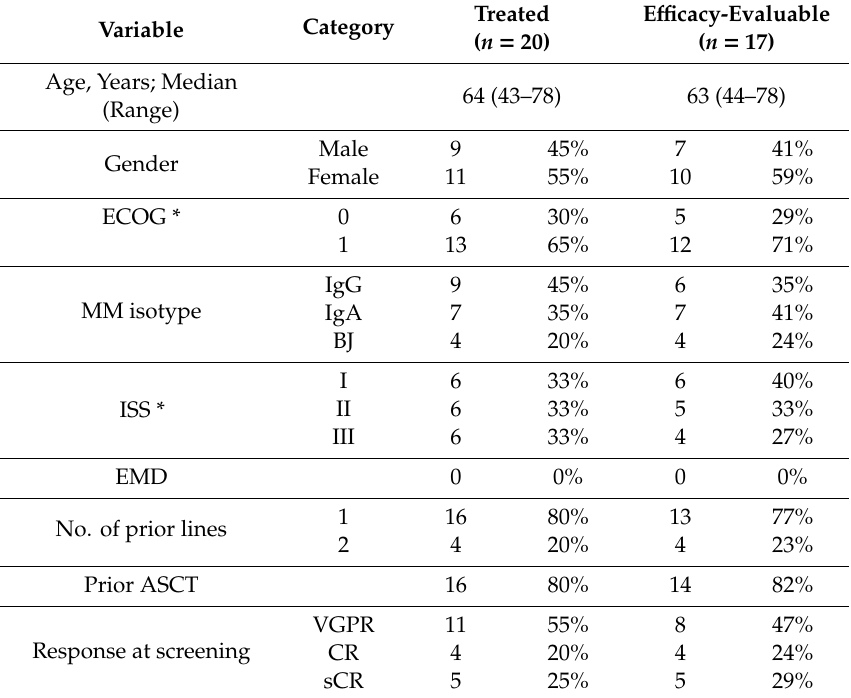
Table 1. Patients’